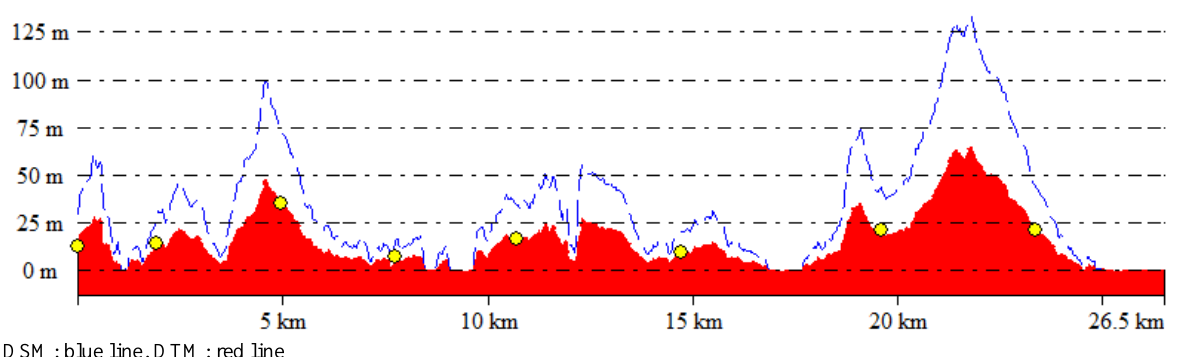
Figure 16. the graph of longitudinal profile